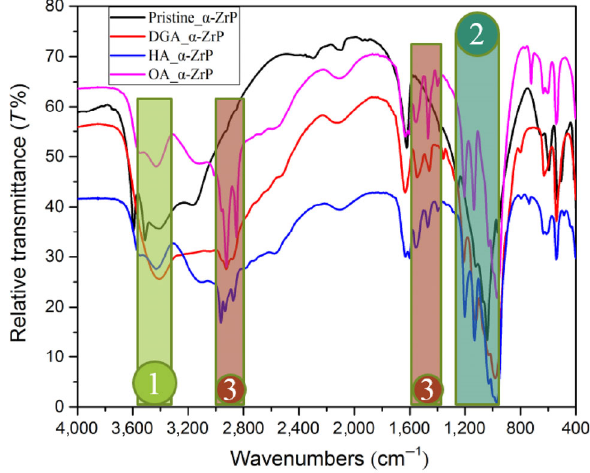
Fig. 3 FT-IR spectra of pristine and amine-intercalated  -ZrP nanosheets.